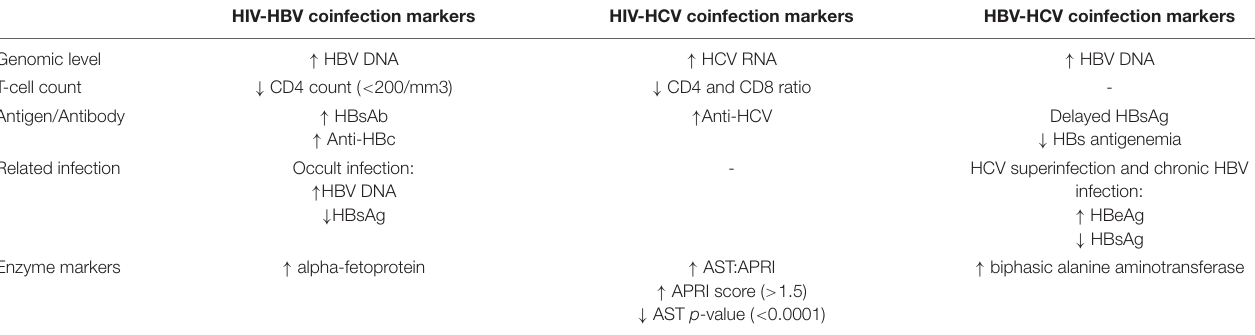
TABLE 2 | Serological markers of HIV-HBV, HIV-HCV, and HBV-HCV coinfection. HIV-HBV coinfection markers HIV-HCV coinfection markers HBV-HCV coinfection markers